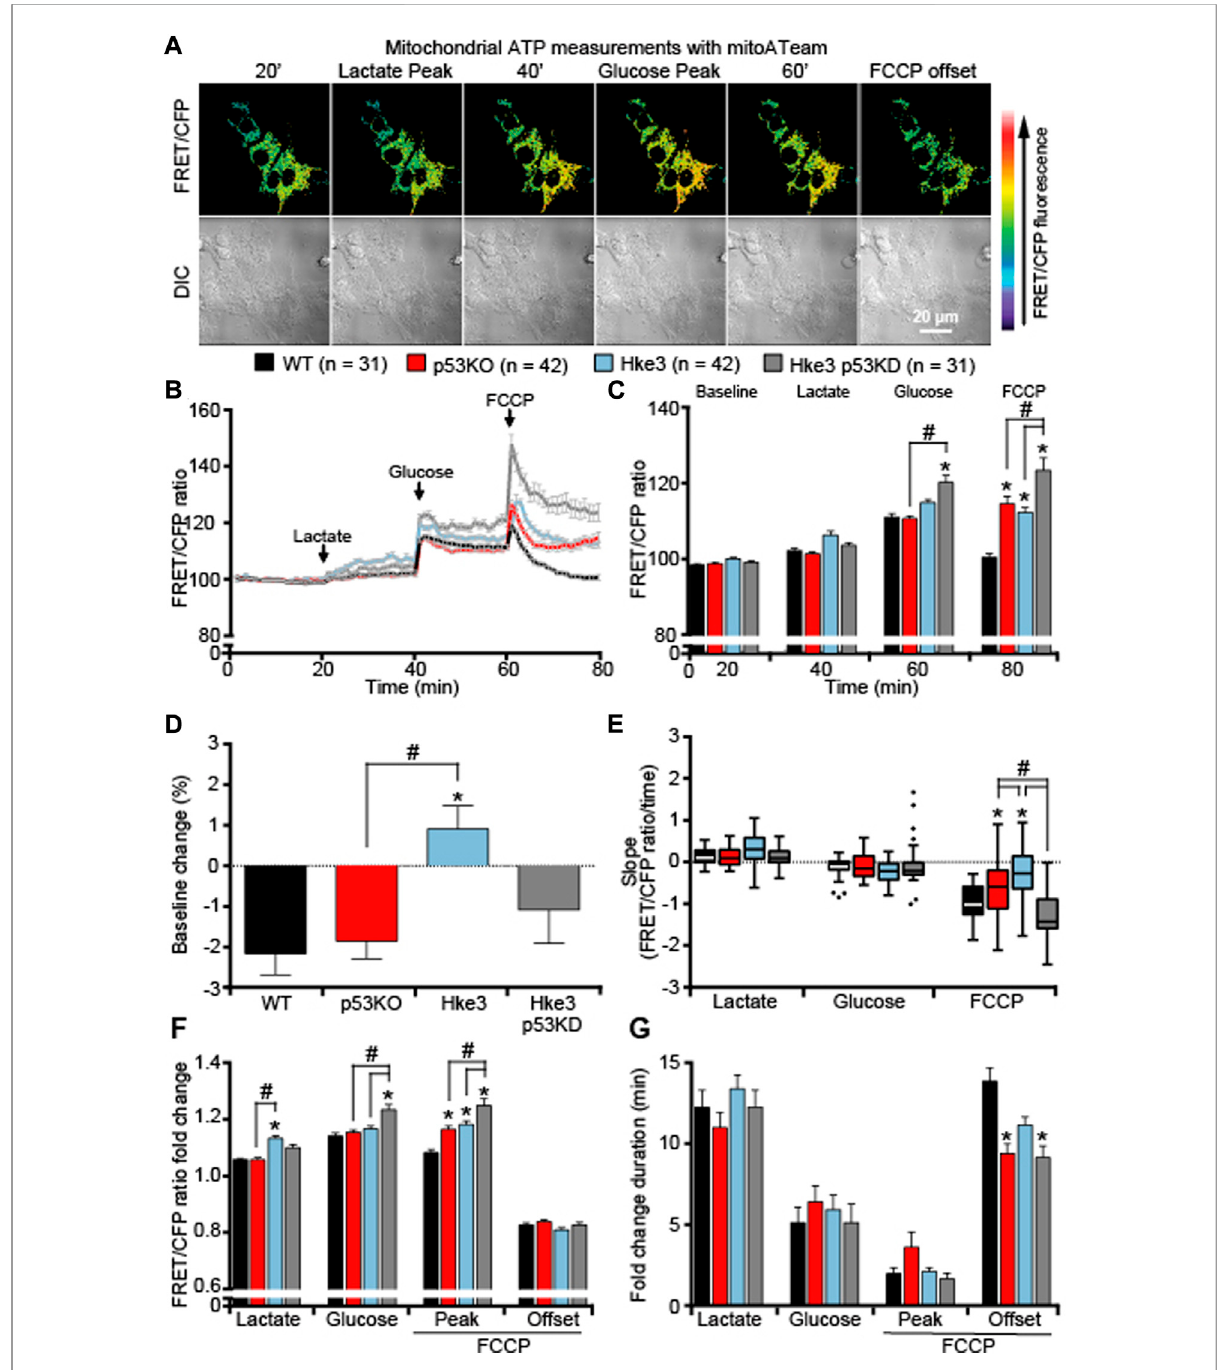
FIGURE 2 TP53 -silenced Hke3 cells with a competent KRAS show signi fi cantly increased mitochondrial ATP levels during metabolic stress. WT, p53 KO, Hke3 and Hke3 p53 KD HCT-116 cells were separately transfected with the mitochondrial ATP-sensitive (mitoATeam) FRET probe, loaded with 30 nMTMRM asa Δ ψ m indicator(non-quenchedmode),mountedontheheated stageofanLSM710confocal microscopeandassayedover80 min at 37 ° C. C ells were exposed as mentioned and illustrated in Figure 1A. (A) Differential interference contrast (DIC) and fl uorescence measurements were recorded for TMRM, FRET, CFP, YFP by time-lapse confocal microscopy. FRET/CFP ratio and DIC representative images of Hke3 cells expressing mitoATeam probeare shown as a ratio of FRET/CFP normalized to baselineto monitor mitochondrial ATP. Scale bar = 20 µm. (B) Kinetics of all cells monitored, expressed as means ± SEM are shown, additions are labelled with black arrows on top of the graph. (C) Analysis of themitochondrial ATP levels (FRET/CFP, normalized) before each drug treatment (20,40 and 60 min) and atthe end ofthe experiment (80 min). (D) Change of mitochondrial ATP baseline levels (FRET/CFP, normalized) over the fi rst 20 min, (E) quanti fi cation of the slope of mitochondrial ATP (the